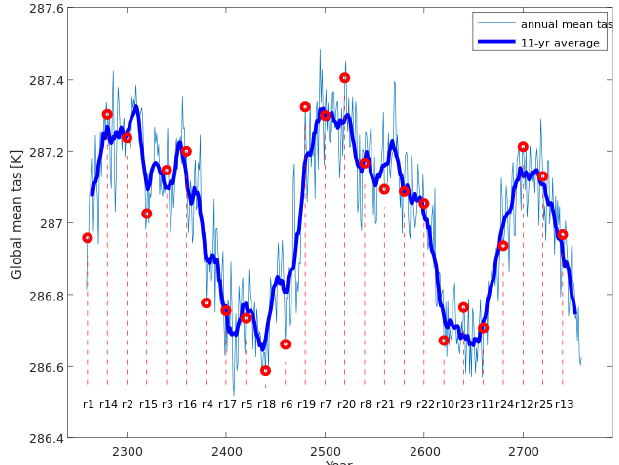
Figure 3. Time series of the global mean of annual mean near- surface temperature (TAS) in the 500-year-long EC-Earth3 piCon- trol experiment. The thick blue line is an 11-year running average of the annual means. The time axis is arbitrary because of constant forcing. Red circles mark the initial states from which the members of the historical experiment are started. The realization_id of the members of the historical ensemble is shown at the bottom of the